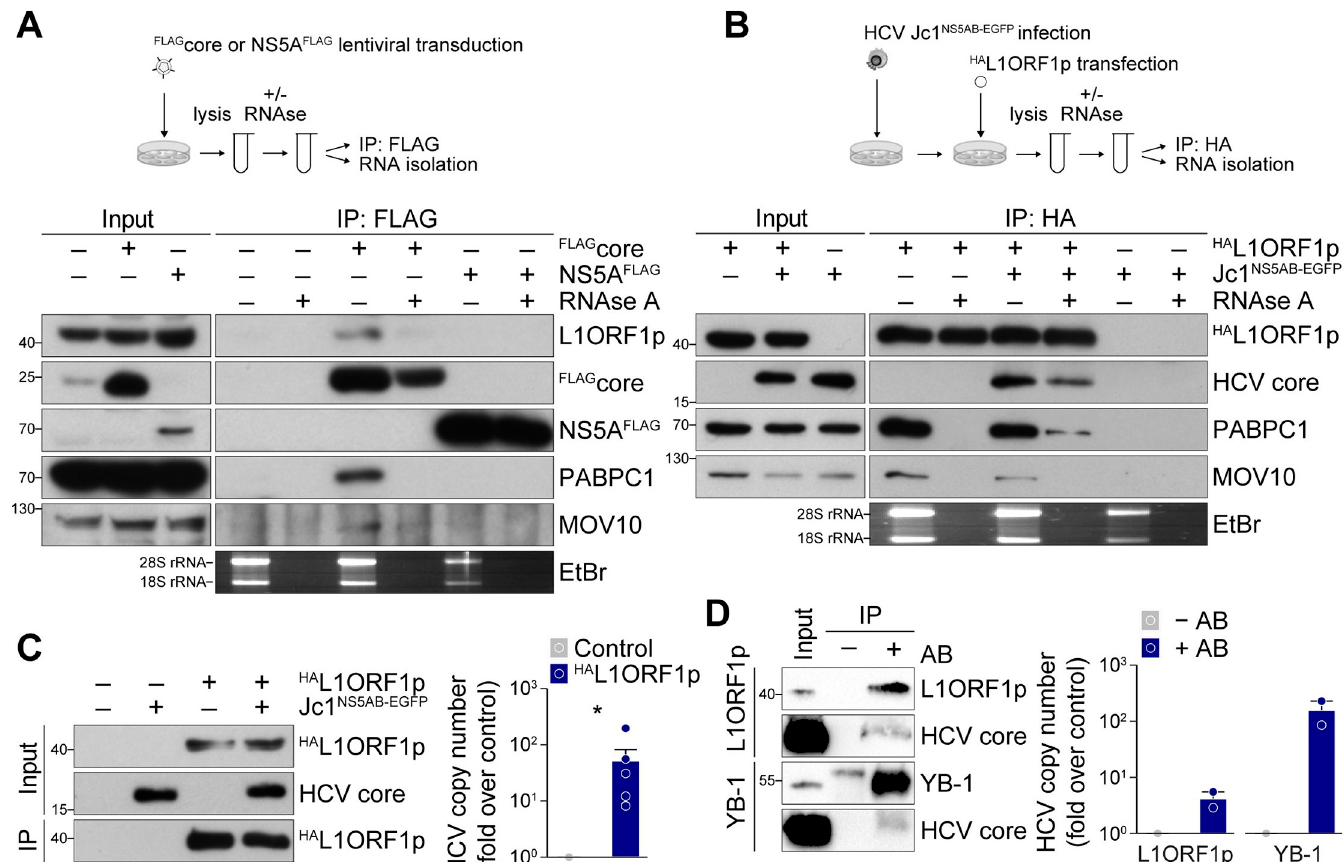
Fig 5. L1ORF1p interacts with HCV core in an RNA-dependent manner. (A) Co-immunoprecipitation analysis of FLAG core or NS5A FLAG with endogenous L1ORF1p and its interaction partners MOV10 and PABPC1. Lysates of cells transduced with lentiviral FLAG core or NS5A FLAG expression constructs were incubated either with RNaseOUT or RNase A followed by FLAG-specific immunoprecipitation and immunoblotting or total RNA isolation and subsequent agarose gel electrophoresis and ethidium bromide (EtBr) staining (bottom panel). Successful RNase A treatment of cell lysates was demonstrated by the absence of 18S and 28S rRNA. Shown is one representative experiment (n = 3). (B) Co-immunoprecipitation analysis of HA L1ORF1p in HCV Jc1 NS5AB-EGFP -infected or mock-infected Huh7.5 cells. Jc1 NS5AB-EGFP - infected (MOI 0.2) or mock-infected Huh7.5 cells were transfected 7 dpi with the HA L1ORF1p expression construct and lysed 2 dpt. RNAse treatment, total RNA isolation, and immunoprecipitation with HA-specific agarose beads were performed as described in (A). One representative experiment is presented (n = 3). (C) HCV RNA co-precipitates with HA L1ORF1p. Relative quantification of HCV RNA copies in immunoprecipitates obtained from Jc1 NS5AB-EGFP -infected Huh7.5 cells transiently expressing HA L1ORF1p. Cells were lysed 2 dpt and 9 dpi and HA-specific immunoprecipitation was performed. Untransfected cells served as control and successful infection and expression of HA L1ORF1p and HCV core as well as immunoprecipitation were confirmed by immunoblotting. HCV copy numbers were quantified by qRT-PCR using a serial dilution of in vitro transcribed HCV RNA as a standard (mean ± SEM, n = 6, � p < 0.05, Mann-Whitney U test). (D) Comparison of HCV RNA copies and interaction with HCV core in immunoprecipitates of endogenous L1ORF1p and YB-1 obtained from from Jc1 NS5AB-EGFP -infected Huh7.5 cells. Expression and immunoprecipitation of L1ORF1p and YB-1 as well as HCV core were analyzed by immunoblotting. Immunoprecipitation without specific antibodies (-AB) served as control. HCV RNA copy numbers were determined as described in (C). Shown are relative HCV RNA copy numbers as fold over control (n = 2).